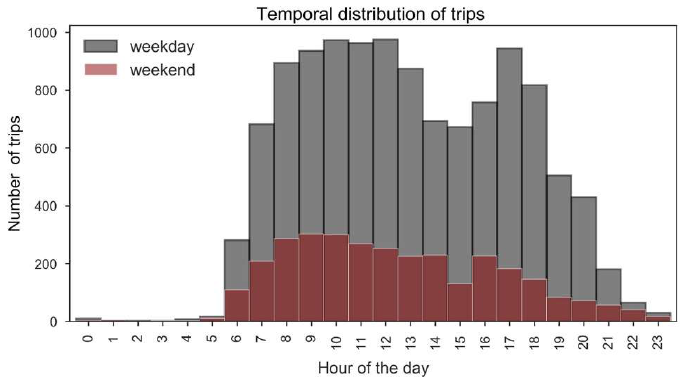
Figure 16. Temporal distribution of trips to Universidade Eduardo Mondlane.